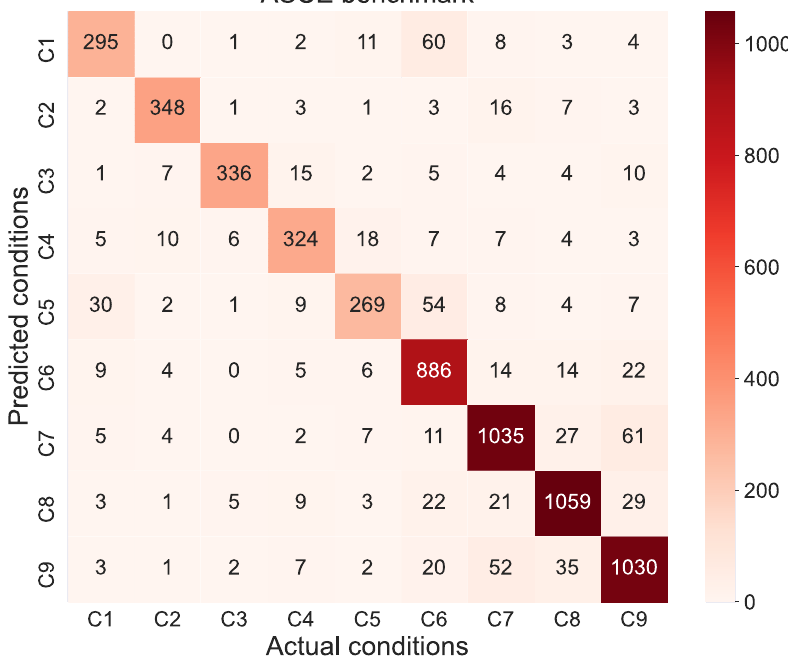
Figure 18. Confusion matrix of damage identification for the Fold-4.